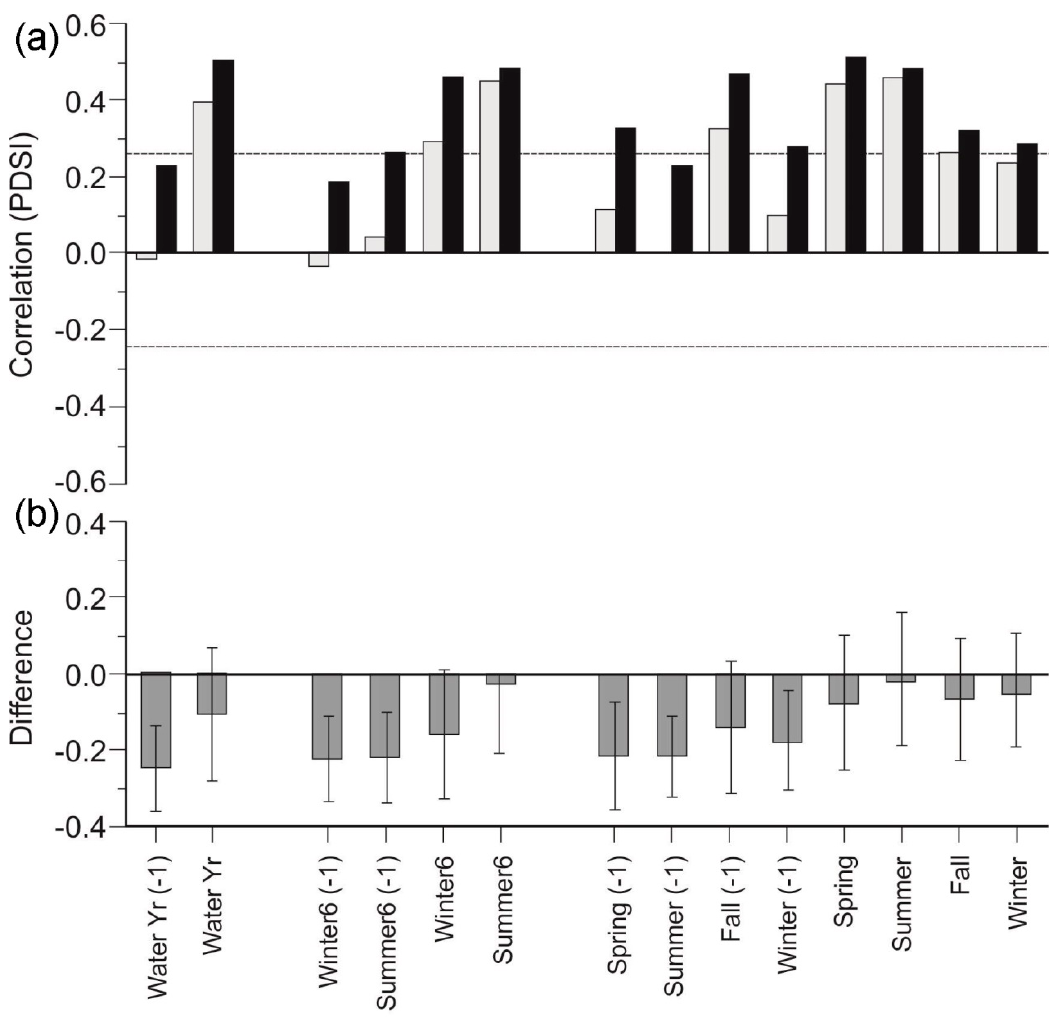
Figure 8. ( a ) Correlations between radial growth index of Oregon white oak growing among conspecifics (light gray) and heterospecifics (solid) and seasonal values of the PDSI (see text for time windows). Significance levels and confidence limits are indicated as in Figure 2. ( b ) Growth–climate response differences for the two chronologies. Positive values indicate that Oregon white oak growing among conspecifics are more positively correlated to the PDSI than Oregon white oak growing among heterospecifics during that season. The error bars indicate the 95% confidence limit on the difference.